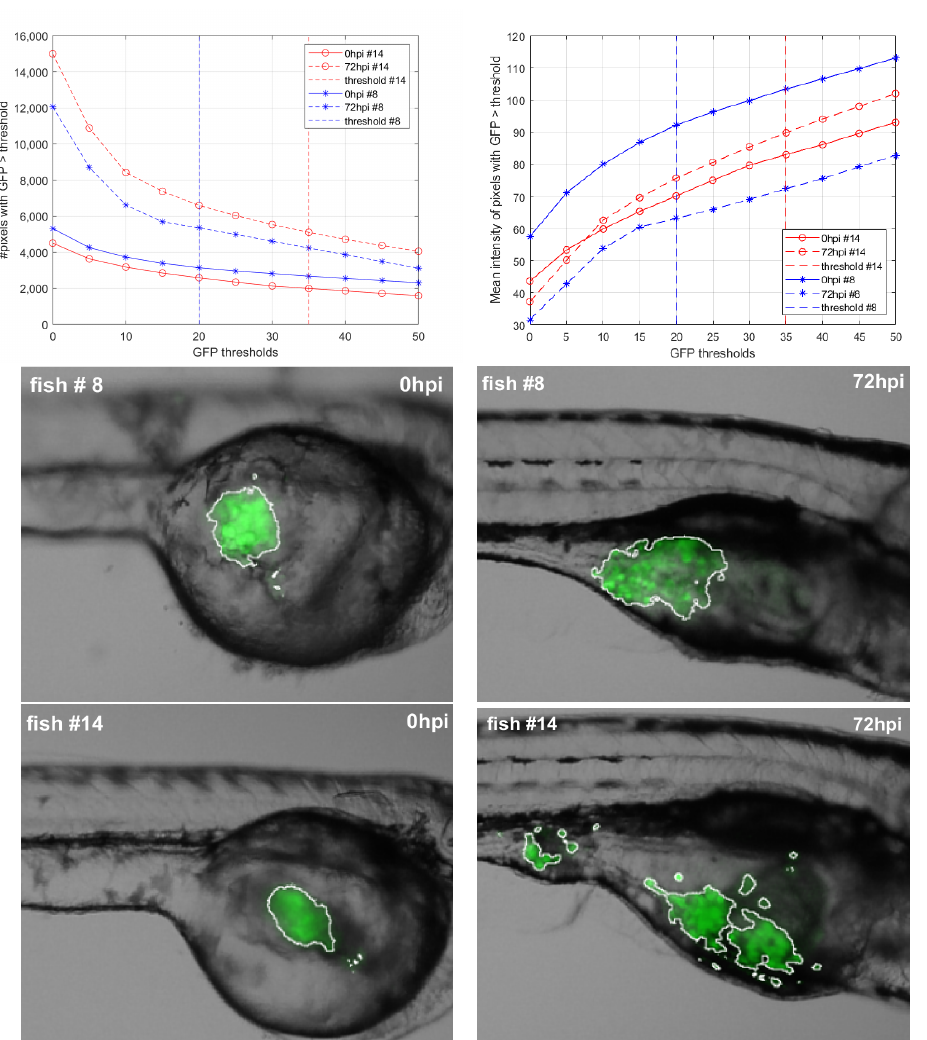
Figure 3. Characteristic zebrafish #8 and #14. Up : fish #8 (blue) presents greater area and lower inten- sity after 72 h while fish #14 (red) presents greater area and higher intensity after 72 h. Threshold final values for zebrafish #8 and #14 are 20 and 35, respectively. Middle and bottom rows: thresholded GFP regions for zebrafish #8 ( middle ) and zebrafish #14 ( bottom ) for 0 hpi ( left ) and 72 hpi ( right ).